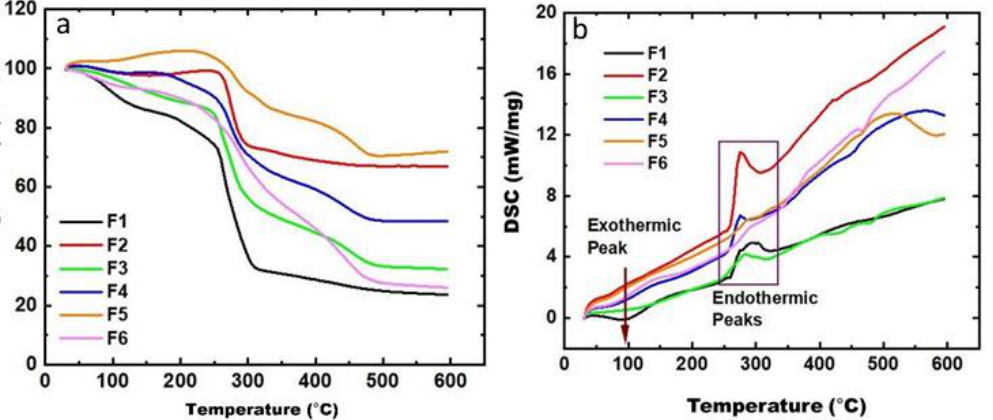
Figure 4. Thermogravimetric analysis of the biocomposite films: thermogravimetric analysis ( a ) and differential scanning calorimetry ( b ). For sample codes F1 to F6, refer to Table 1.